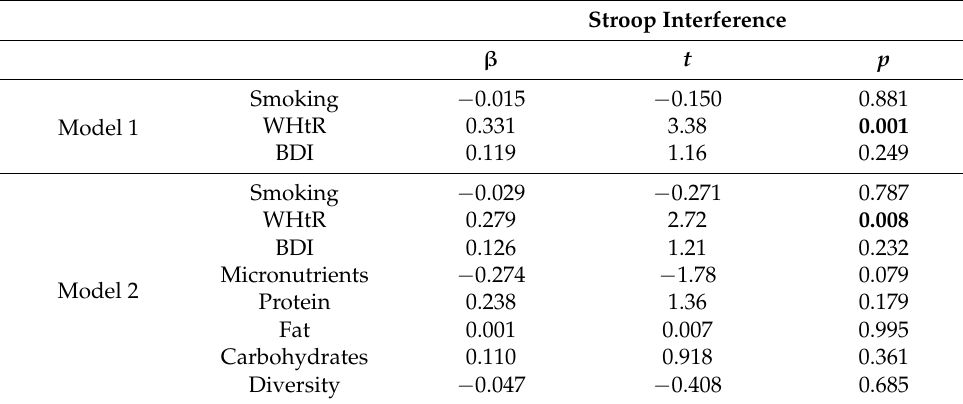
Table 5. Association of nutritional behavior with Stroop interference.